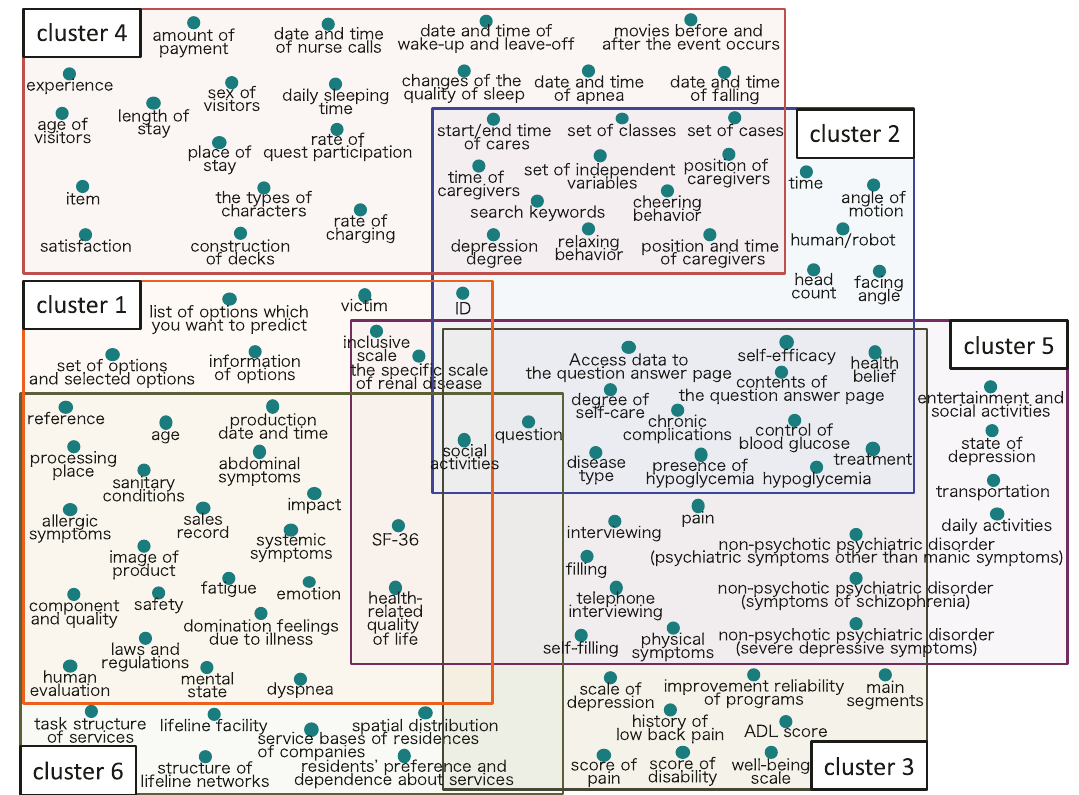
Figure 8: The clustering of VLs inferred from the terms to explain Belief Drift.